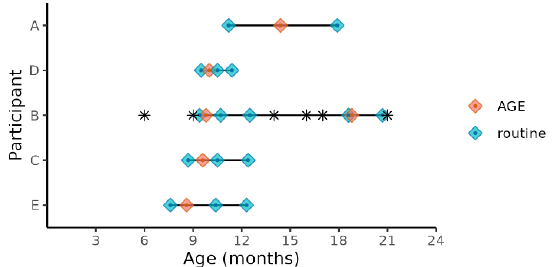
Figure 1. Child age at sample collections times before, during, and after norovirus-associated AGE. Diamonds indicate the child’s age at sample collection time points. Samples collected before and after AGE are indicated as “routine”. The children’s ages when antibiotics were administered are indicated by * .